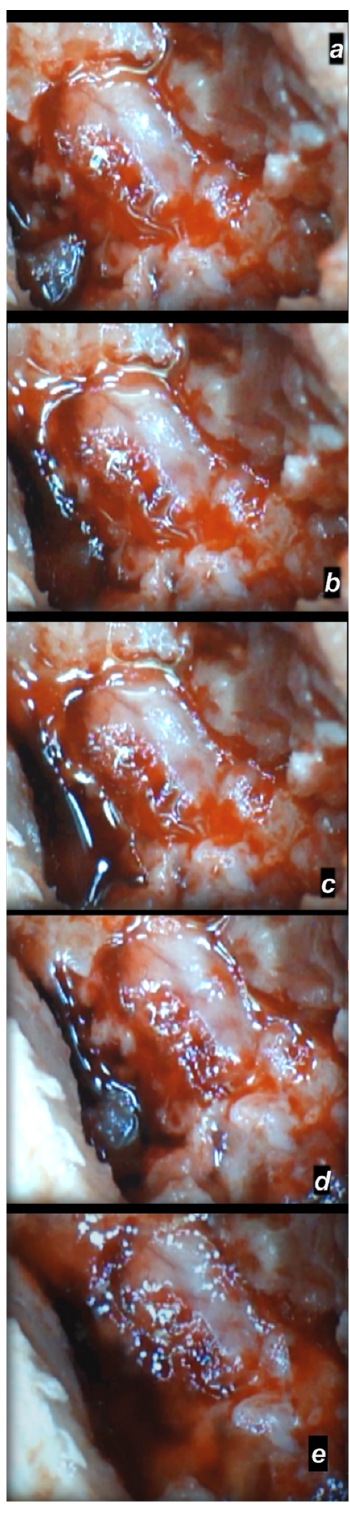
Figure 7. Spinal cord swelling and hematoma presentation following spinal cord compression (for 1 min), presentation at day 4 following injury (a camera attached to a VMS-004 Discovery Deluxe USB microscope (Veho, Denver, CO, USA)). Presentation before therapy ( a ), and, ( b – e ) after saline (5 mL/kg ig) application, immediately ( b ), at 5 min ( c ), at 10 min ( d ), and at 20 min ( e ).